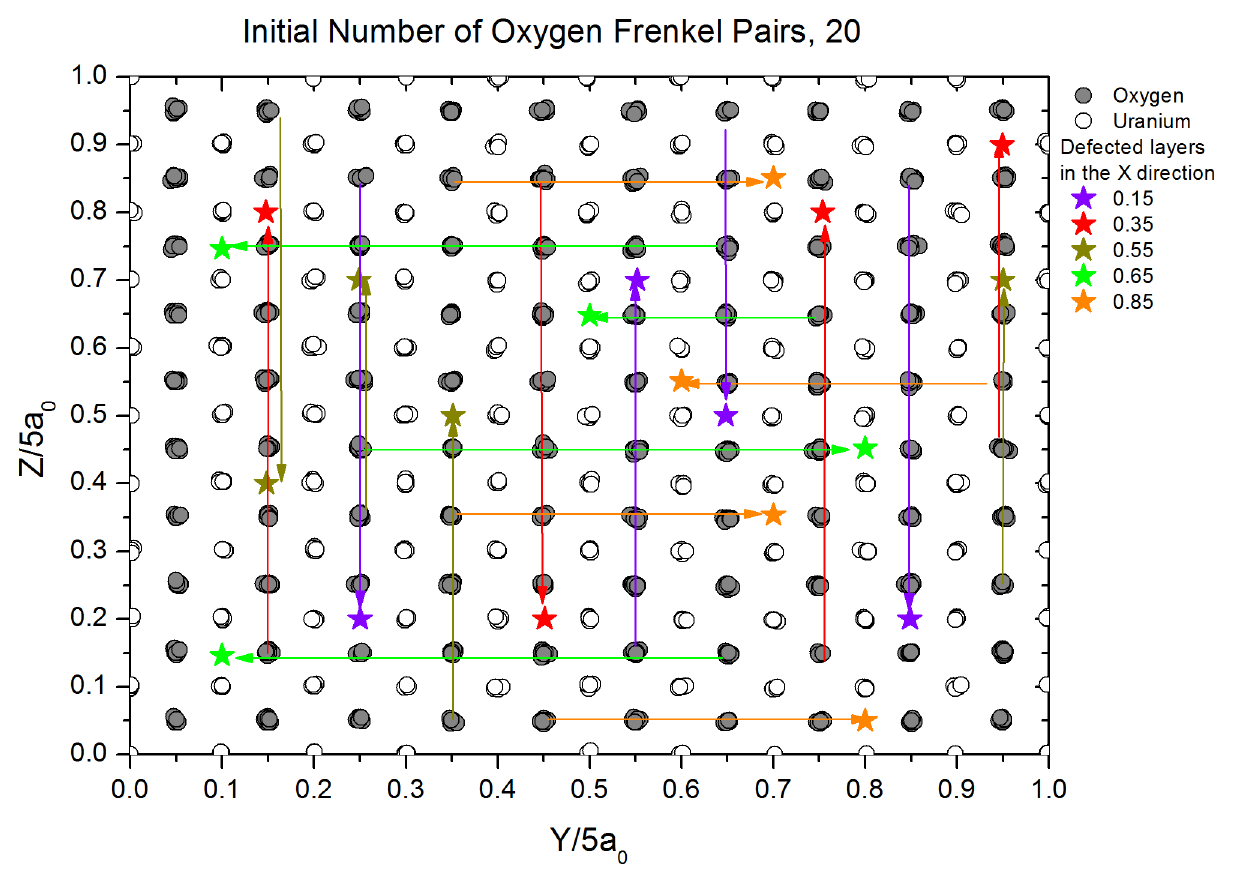
Fig 1. Initial view from the x direction of a MD supercell sample with 20 oxygen IFPs. Arrows indicate the displacements of atoms from their lattice sites to their interstitial positions. Each color represents a different layer along the x direction.